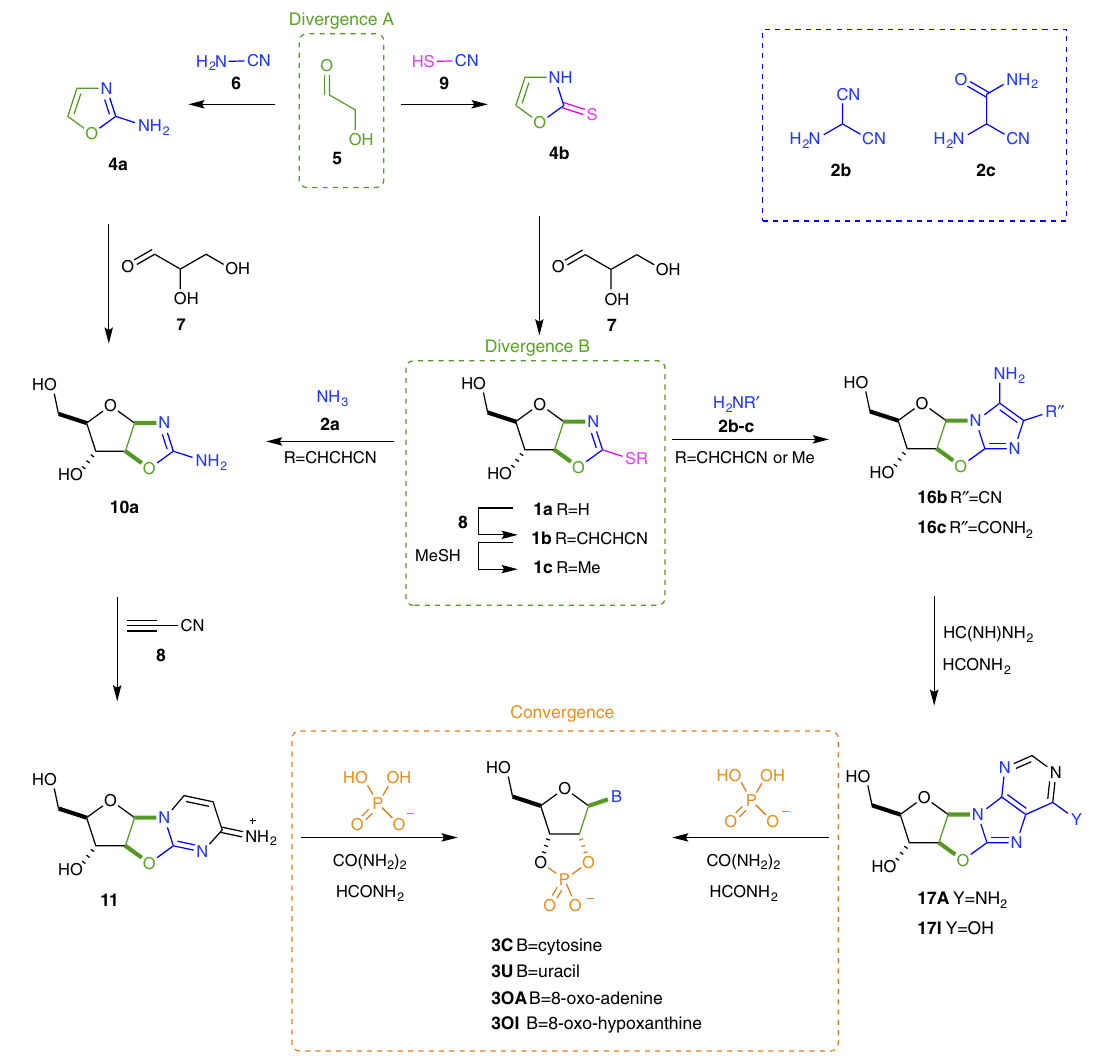
Figure 2 | Divergent ribonucleotide synthesis. Prebiotic assembly of cytidine-2 0 ,3 0 -cyclic phosphate 3C , uridine-2 0 ,3 0 -cyclic phosphate 3U , 8-oxo- adenosine-2 0 ,3 0 -cyclic phosphate 3OA and 8-oxo-inosine-2 0 ,3 0 -cyclic phosphate 3OI . Glycolaldehyde ( 5 ) reacts with cyanamide ( 6 ) and thiocyanic acid ( 9 ) to furnish 2-aminooxazole 4a and 2-thiooxazole 4b , respectively. 2-Aminooxazole 4a is a known prebiotic precursor of pyrimidine nucleotides ( 3C and 3U ) and 2-thiooxazole 4b is demonstrated to be a precursor of both pyrimidine nucleotides ( 3C and 3U ) and 8-oxo-purine nucleotides ( 3OA and 3OI ). Oxazole 4b undergoes reaction with glyceraldehyde ( 7 ) to yield thione 1a . Chemical activation of thione 1a provides a second point of divergence (thione 1b ), which yields pyrimidine precursor 10a upon reaction with ammonia ( 2a ) or purine precursors 16b or 16c upon reaction with hydrogen cyanide oligomers ( 2b or 2c , respectively). Cyanovinylation and formylation of 10a and 16b/c and subsequent urea-mediated phosphorylation leads to the congruent synthesis of pyrimidine nucleotides ( 3C and 3U ) and 8-oxo-purine nucleotides ( 3OA and 3OI ). The two points of chemical divergence, Divergence A and divergence B, are marked with green boxes and the chemical convergence, Convergence, on nucleotide monomers is marked with an orange